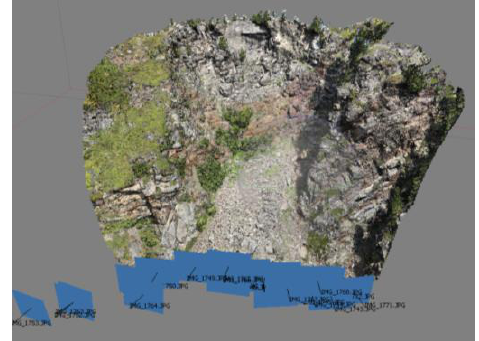
Figure 2. Image positions during the data acquisition stage. The reference point-cloud is a terrestrial laser scan, acquired with a Riegl VZ-2000 on the first day. The average point spacing was set to 3 cm. Measurements were taken from three different scanning positions, roughly within the same distance to the rockfall site as the ground photos. The location of each scanning position was georeferenced using differential GNSS. It should be mentioned that no manmade control points were placed on the rockfall site due to its inaccessibility. The resulting uncertainties will not play a vital part in the model since the morphological signs of mass movement are in larger magnitude from the Ground Sampling Distance (GSD).